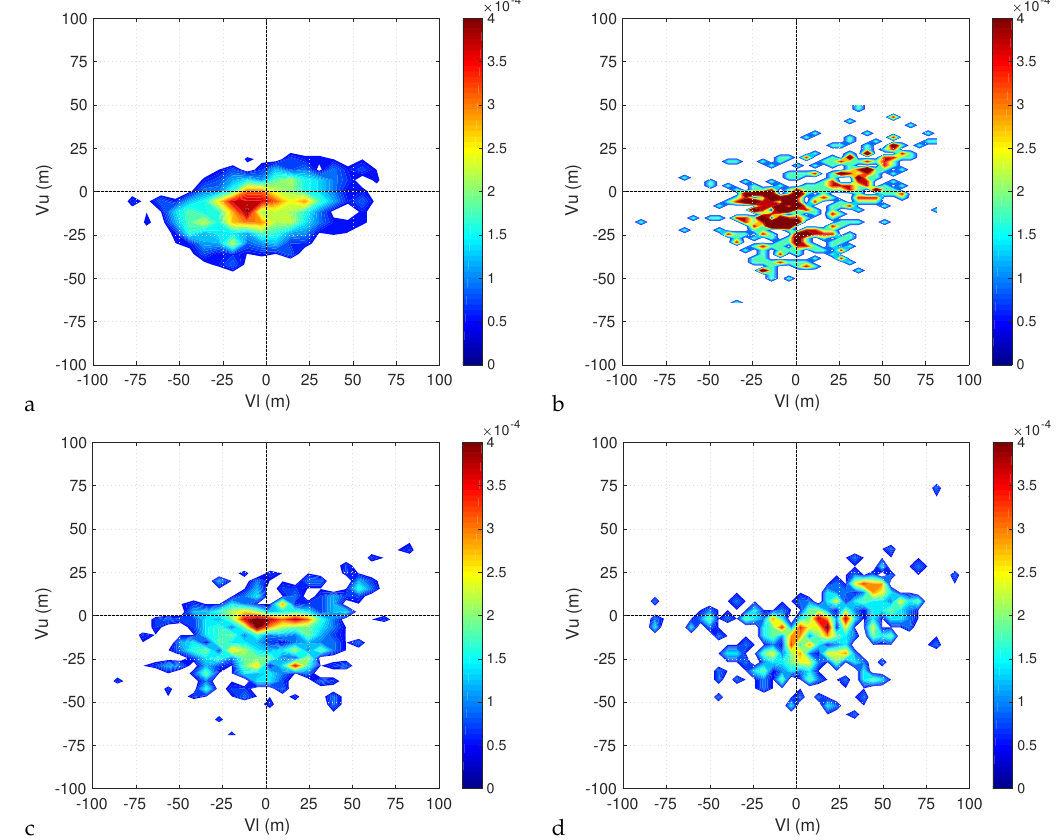
Figure 8. Density of Vl and Vu Hart parameters for the et04 ( a ), bt11 ( b ), kt11 ( c ) and kw11 ( d ) simulations for G = 3.21 × 10 − 2 hPa km − 1